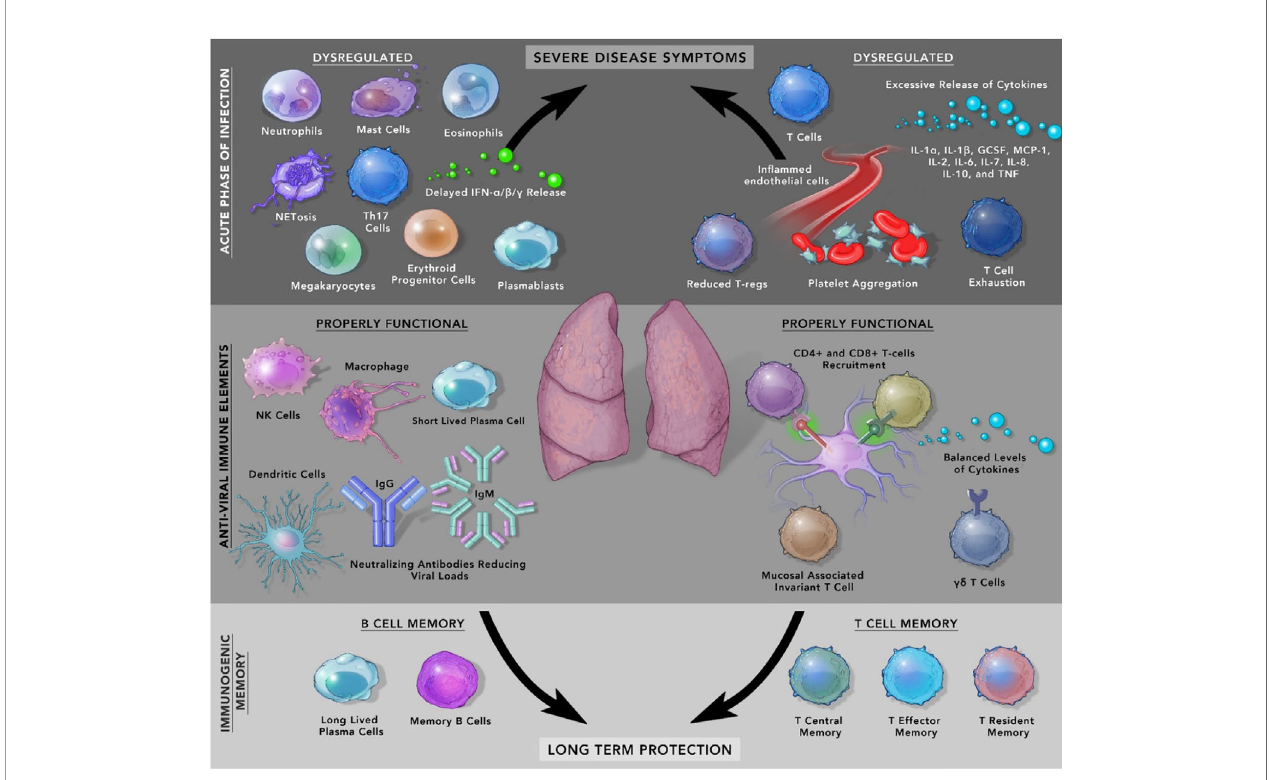
FIGURE 1 | Mediators of Immunopathology in SARS-CoV-2 infection and